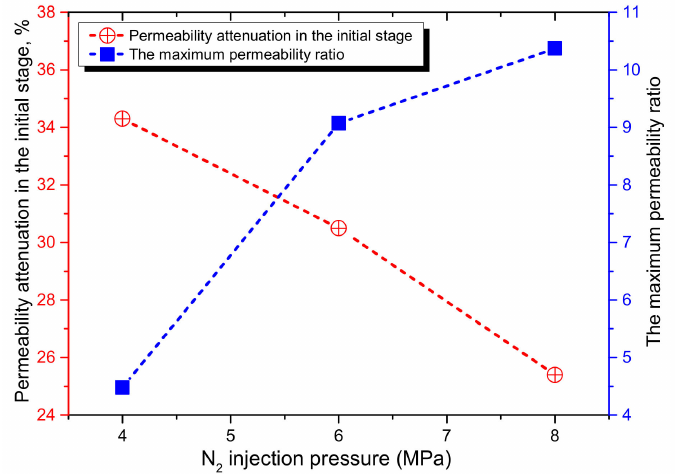
Figure 6. Variation of the permeability attenuation in the initial stage, and the maximum permeability ratio with the N 2 injection pressure.